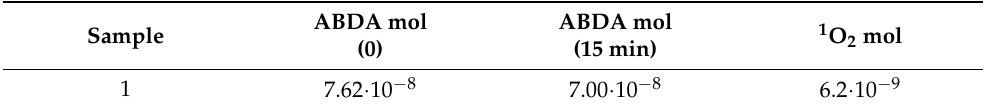
Figure 3. Singlet oxygen generation detected by ABDA method. ( a ) Photobleaching of ABDA by singlet oxygen at different irradiation times (0–15 min) in water, and ( b ) in presence of 1 (8 · 10 − 5 M). The experiments were carried out by using an ABDA concentration of 2.4 · 10 − 4 M and a laser beam at 800 nm (100 mW) as excitation source; ( c ) plotting of ABDA absorption at 378 nm as a function of the illumination time. Table 1. Moles of 1 O 2 generated after light exposure of 1 ( λ ex 800 nm-100 mW-15 min) and calculated from the amount of reacted ABDA molecules.